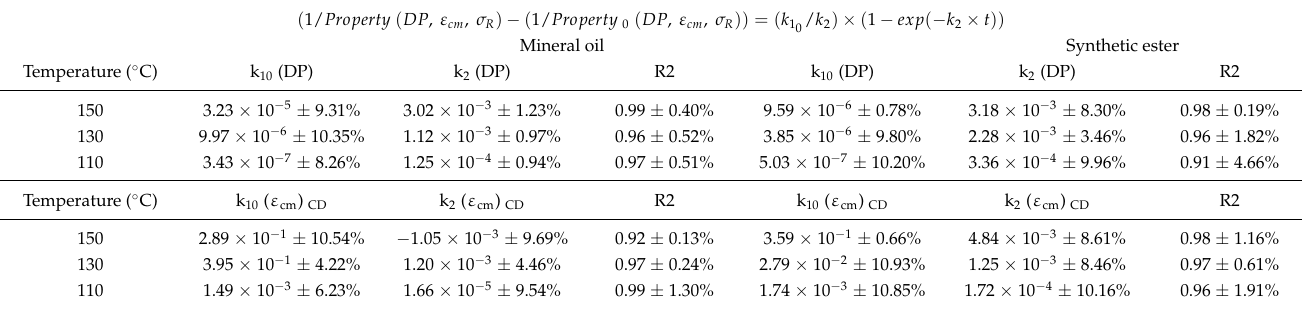
Table 5. Constant rates of reaction for the Emsley model based on DP, ε cm, and σ R for different insulation